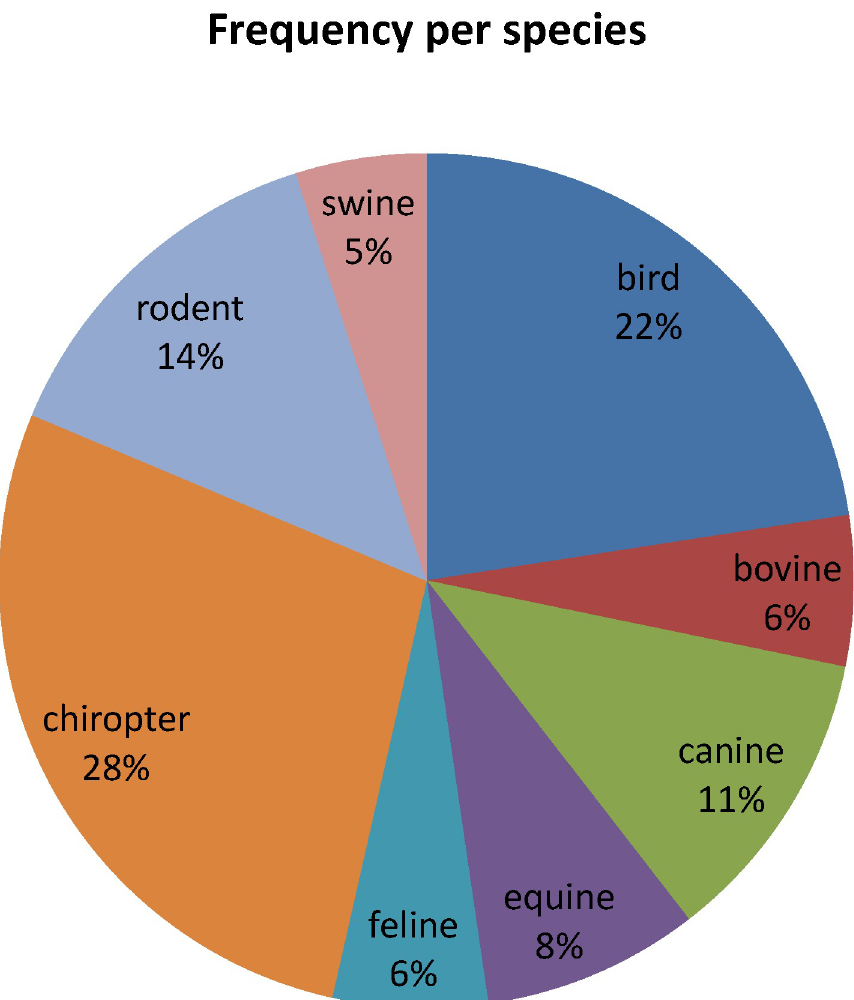
Fig 3. Frequency of Rotavirus A in domestic and wild animals in the Brazilian Amazon from 2014 to